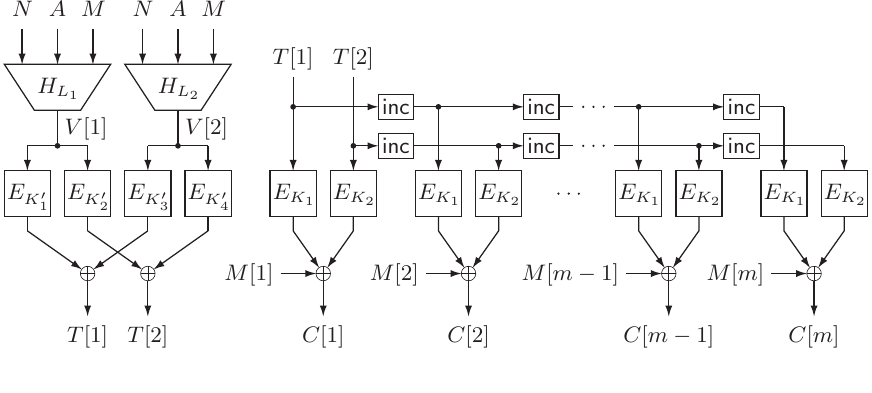
( M ) and GCM-SIV2- D N,A K